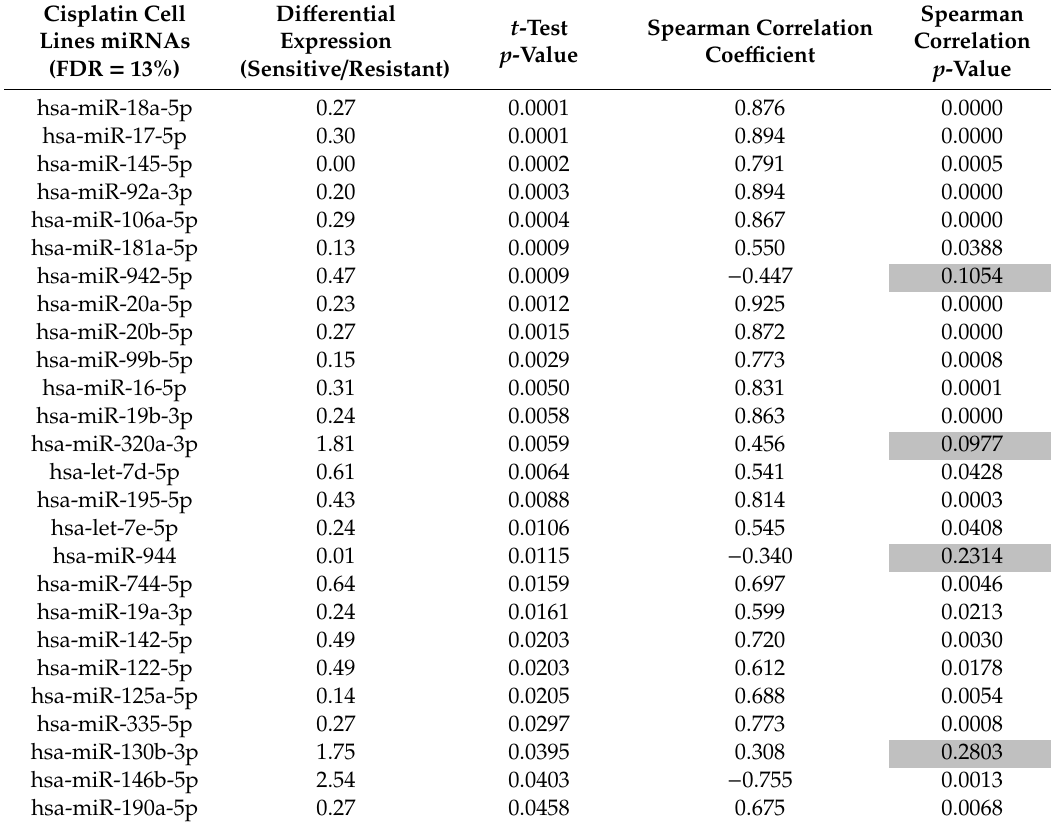
Table 2. miRNAs that were associated with treatment response to cisplatin in OAC cell lines. Significant treatment response was measured as (i) di ff erential expression between cell lines that had low vs. high survival fractions, and (ii) non-parametric correlation of expression levels with survival fractions across all cell lines. miRNAs with Spearman correlation p -values > 0.05 are highlighted in